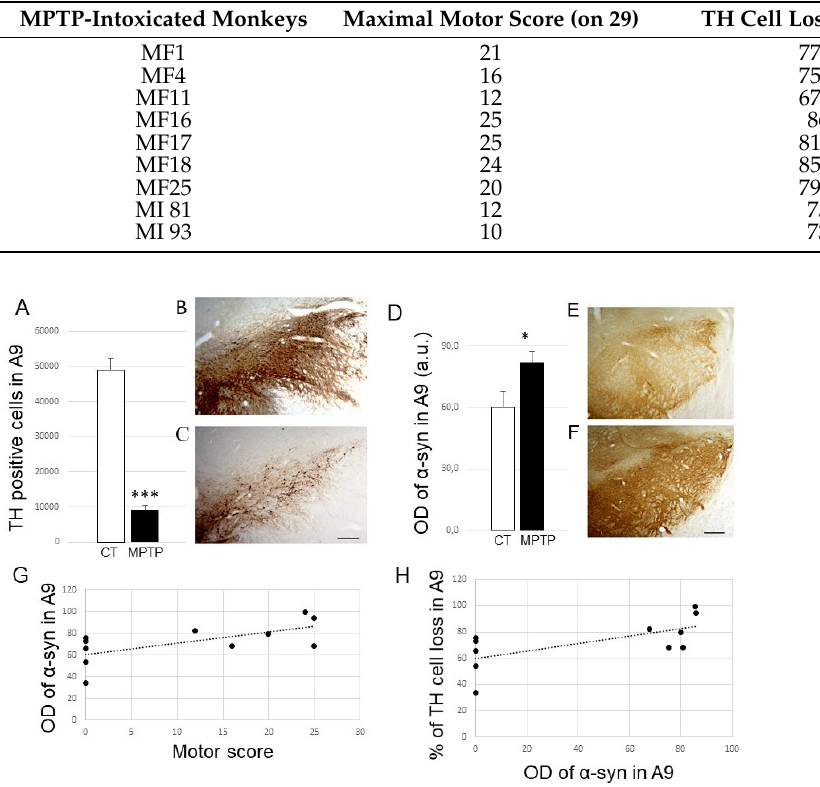
Figure 1. ( A ) Histogram represents the number of TH-positive cells in A9 from control (CT, n = 5) and MPTP-intoxicated (MPTP, n = 6) animals. *** p < 0.001 when compared to controls. ( B , C ) Photomicro- graphs at low magnification ( × 2.5) of coronal sections of a control (MF14) and an MPTP-intoxicated Macaca fascicularis (MF18), exemplifying TH labeling obtained at the level of the substantia nigra. Scale bar on panel C is 400 µ m. ( D ) Histogram represents optical density of α -syn (in arbitrary units) in A9 from control (CT, n = 4) and MPTP-intoxicated (MPTP, n = 6) animals. * p < 0.05 when compared to controls. ( E , F ). Photomicrographs at low magnification ( × 2.5) of coronal sections of a control (MF15) and an MPTP-intoxicated (MF18) Macaca fascicularis, exemplifying α -syn labeling obtained at the level of the substantia nigra. Scale bar on F is 400 µ m. ( G , H ) Positive correlation observed between the expression levels of α -syn (OD expressed in arbitrary units) in A9 and the maximal motor score ( G ) or the percentage of TH cell loss in A9 ( H ). Abbreviations: a.u, arbitrary units; OD, optical density; CT, control; TH, tyrosine